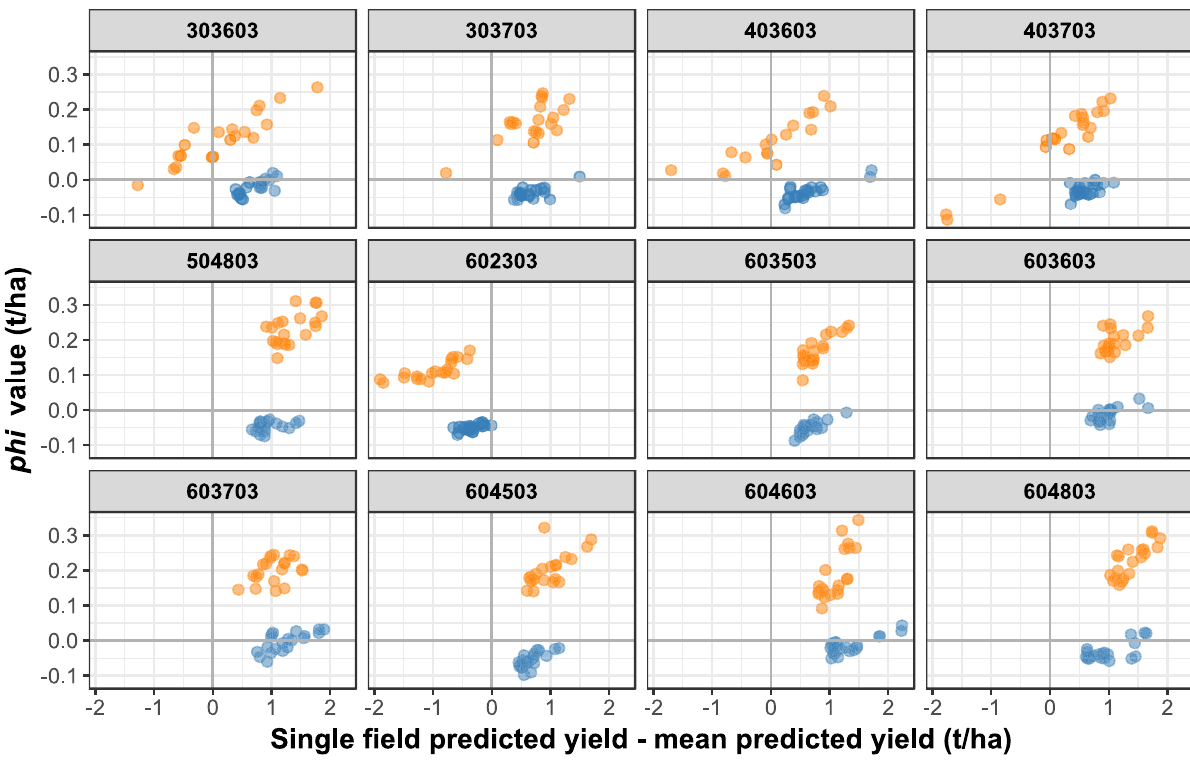
Figure 3. Shapley phi values attributed to foliar fungicide use for two cohorts of fields within the 12 technology extrapolation domains (TEDs) with the most fields. Within each TED, the cohorts are the 20 highest-yielding fields among those sprayed with foliar fungicides and the 20 highest-yielding fields among those which were return (with respect to fungicide use) was less than US$7.50/ha. For these four TEDs, confidence intervals for the mean financial return per ha after accounting for fungicide costs indicated returns could be negative (loss), zero, or up to US$26.50/ha, depending on the individual field (Supplementary Figure S9 online). Considering these were the highest-yielding fields within TEDs, there was the risk of losing money on fungicide sprays in these four TEDs. Obviously, environment mattered (compare with Supplementary Figures S5 and S6 online), and with the four TEDs listed above the most noticeable feature was their higher-latitude locations relative to fields in other TEDs. Among other things, higher latitude is associated with cooler weather and shorter accumulation of GDD. Underlying yield potential factors (early sowing, PAWR, GDD, AI) contributed to higher predicted yield. Higher-yielding environments were more likely to also realize a larger contribution of foliar fungicides to yield above the global average (Supplementary Figure S6 online), thereby leading to the profitability of spraying. The financial return on spraying the fields in s 2 c 2 (100 lowest-yielding fungicide-sprayed fields) was negative, except in a few individual cases (Supplementary Figure S10 online). The mean net return due to foliar fungicides for s 2 c 1 (100 highest-yielding fungicide-sprayed fields) was US$74.63/ha (95% CI US$69.02 to US$80.66 per ha), whereas for s